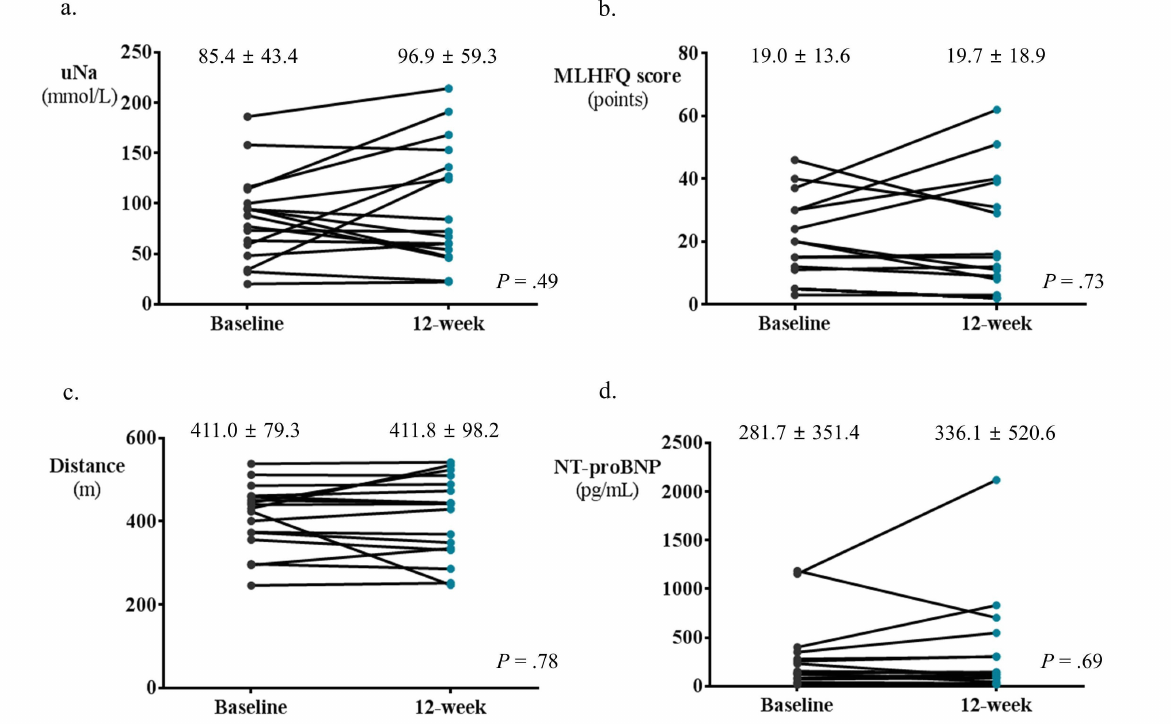
Figure 6. Changes in major outcomes over time by information communication technology (ICT)–based telehealth program in patients without good adherence. In patients without good adherence, no significant changes were observed in laboratory and functional outcomes after 12 weeks of ICT-based telehealth program (a-d). NT-proBNP: N-terminal prohormone of brain natriuretic peptide, MLHFQ: Minnesota Living with Heart Failure